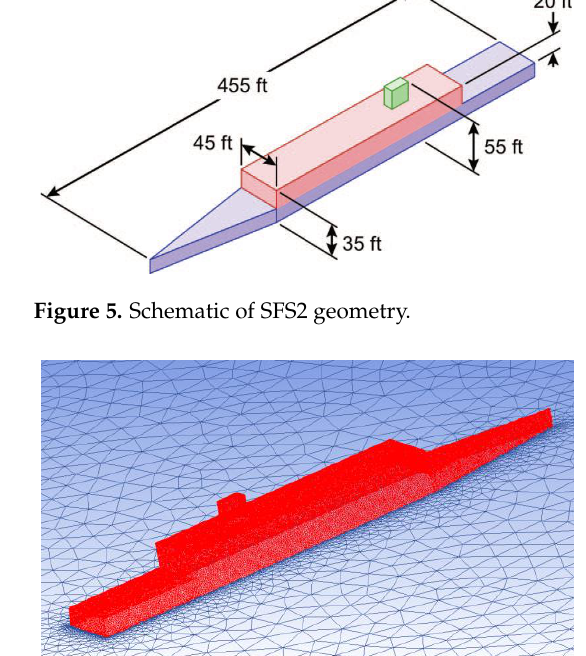
Figure 5. Schematic of SFS2 geometry.